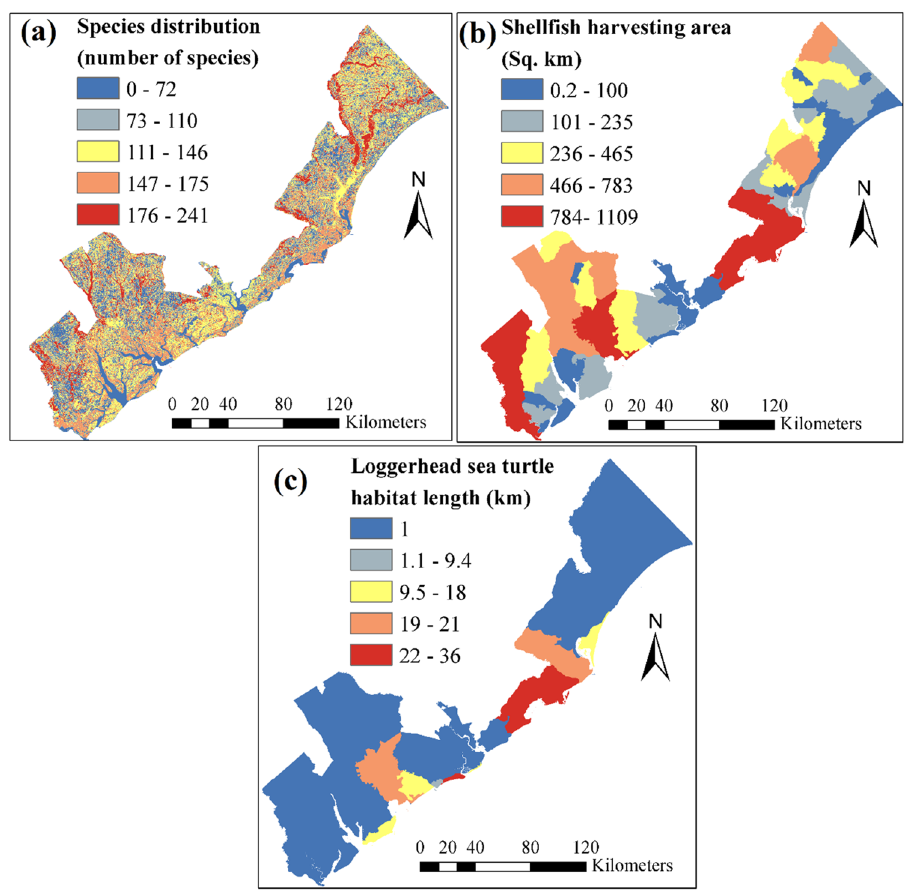
Figure 7. Ecological vulnerability indicators ( a ) Species richness, ( b ) Shellfish harvesting area, ( c ) Loggerhead sea turtle